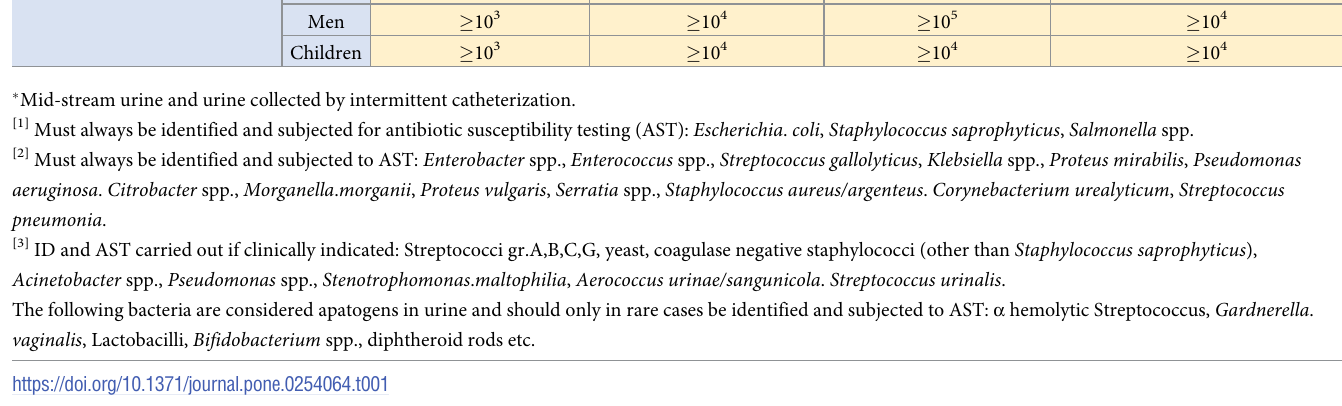
Table 1. Significant values for different uropathogens in different patient groups. (Adapted from Norwegian national guidelines for diagnosing bacterial urinary tract infections) [4]. Patient group Pure culture SymptomaticPatients(MSU and IC)